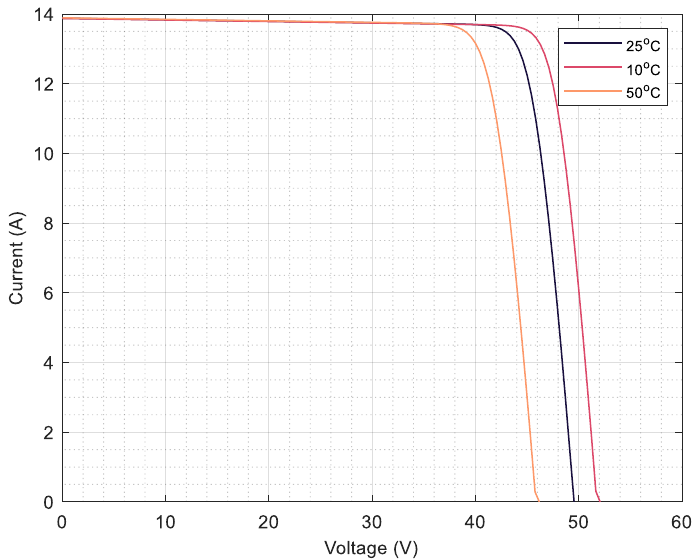
Figure 8. Temperature-dependent PV module current output.